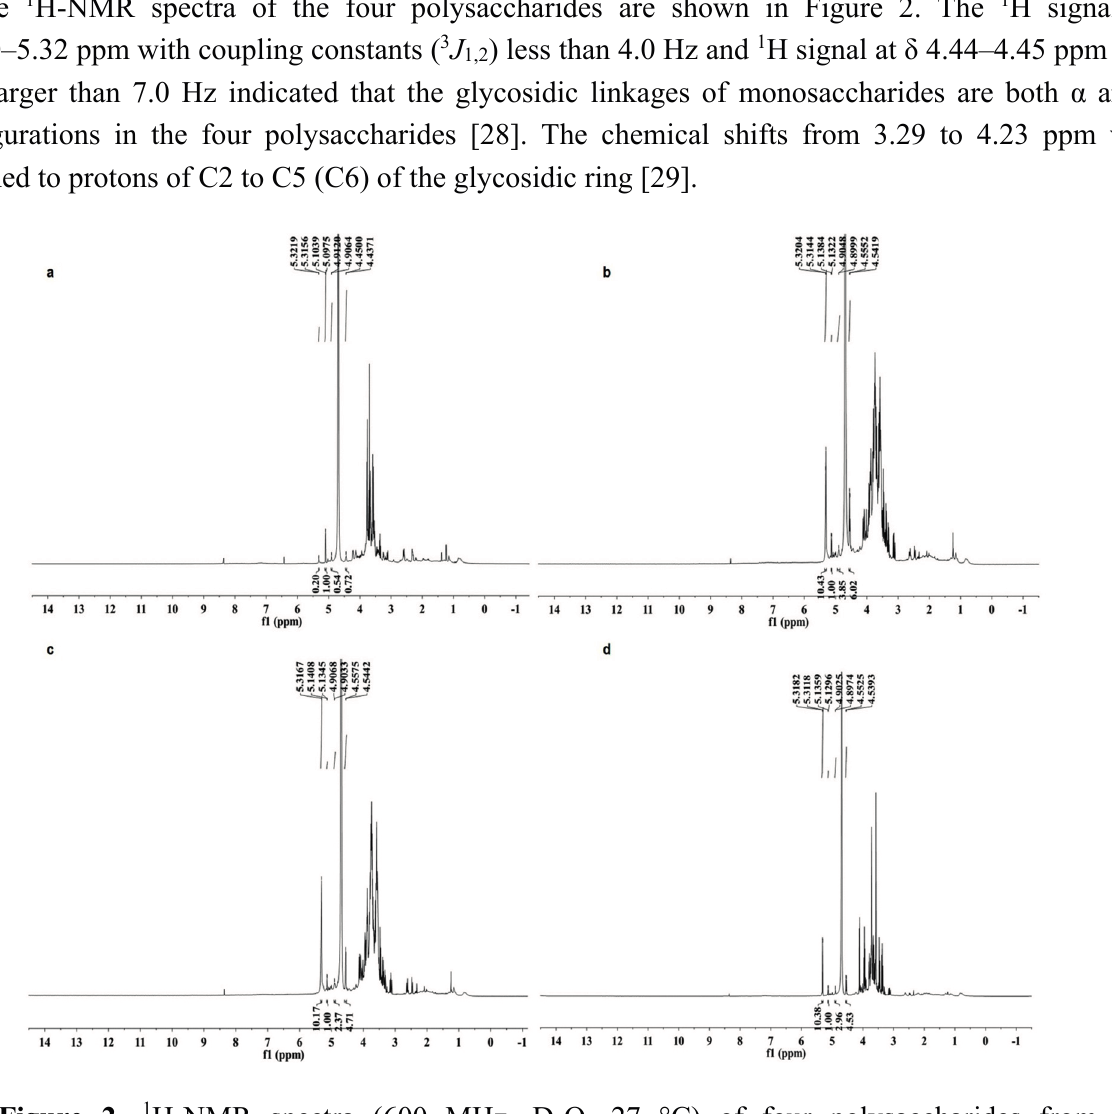
spectrophotometer over the frequency range of 400–4000 cm − 1 .